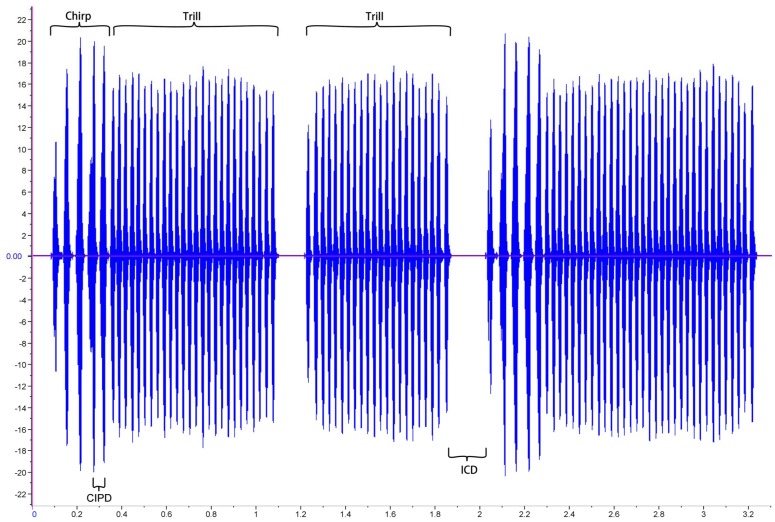
The advertisement call of T. commodus.Each phrase consists of a single chirp followed by a variable number of trills (the phrase in the figure has two trills). We measured: dominant frequency (DF), chirp pulse number (CPN), chirp inter-pulse duration (CIPD), inter-call duration (ICD), and trill number (TN). The vertical axis represents the amplitude of the sound produced.